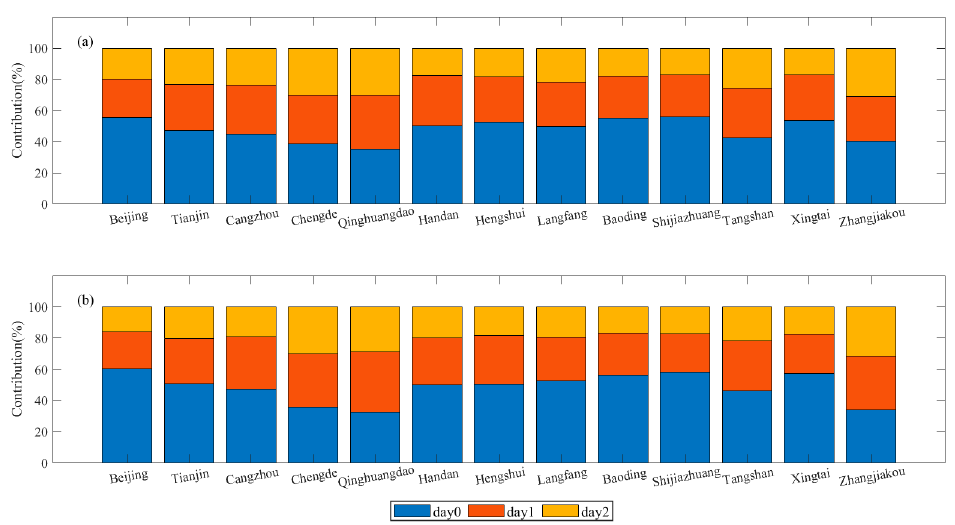
Figure 8. O 3 temporal source apportionments by source regions in cities on the NCP ( a ) monthly average results; ( b ) during O 3 episodes (day 0: contributions on the day of emission; day 1: emissions on the previous day; day 2: emissions two or more days earlier).